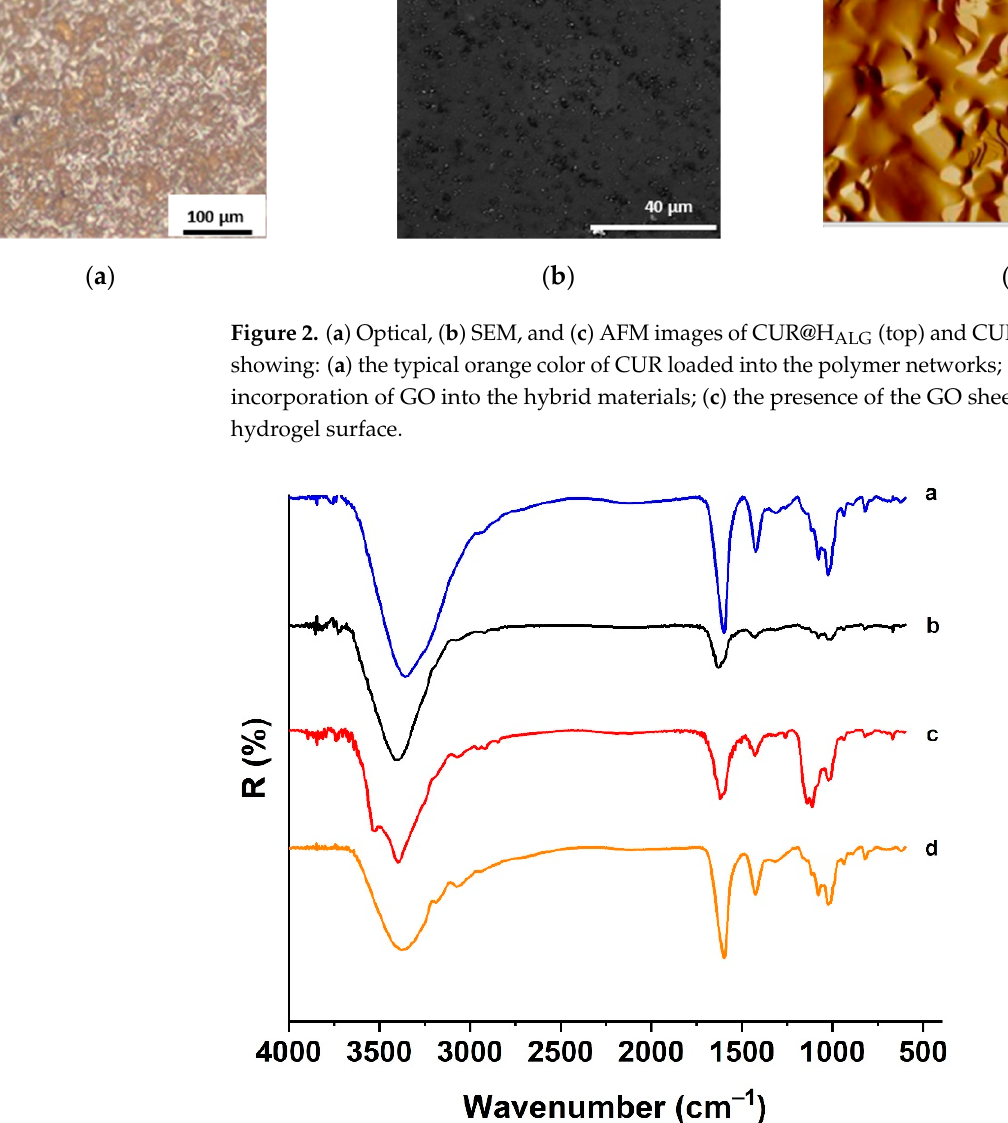
Figure 3. ATR-FTIR spectra of ( a ) ALG, ( b ) GO, ( c ) CUR, and ( d ) CUR@H ALG-GO . The ALG showed bands at 3000–3600 cm − 1 (stretching of OH bonds) and 1600–1422 cm − 1 (asymmetric and symmetric stretching of carboxyl groups) [53]. The same groups were found in GO, with the stretching of OH and COOH located at 3399 and 1753 cm − 1 [54], respectively, whilst the peak at 1074 cm − 1 was attributed to the stretching of the C-O